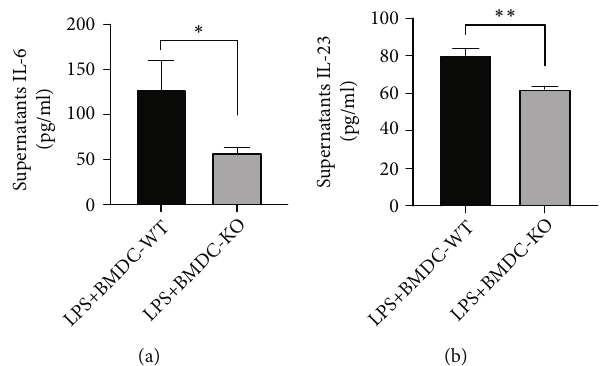
Figure 6: IL-33 de fi ciency impairs IL-6 and IL-23 production by BMDCs. BMDCs were induced and stimulated with LPS, and the concentrations of IL-6 (a) and IL-23 (b) in the culture supernatant were measured by ELISA. The data are expressed as the means ± SDs . Signi fi cant di ff erences are shown by ∗ P < 0 : 05 , ∗∗ P < 0 : 01 , and ∗∗∗ P < 0 : 001 by unpaired Student ’ s t -tests comparing the WT and IL-33- KO groups. N = 3 for each group, and three independent repeated experiments were carried